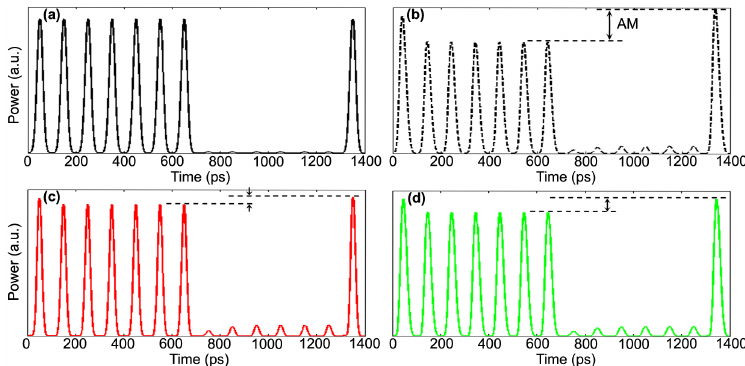
Figure 7. Simulated temporal waveforms that contain maximum strings of ‘1’s and ‘0’s. ( a ) SOA input, ( b ) SOA output, ( c ) ODI output and ( d ) MRR output. The vertical arrows indicate the amplitude modulation ( AM